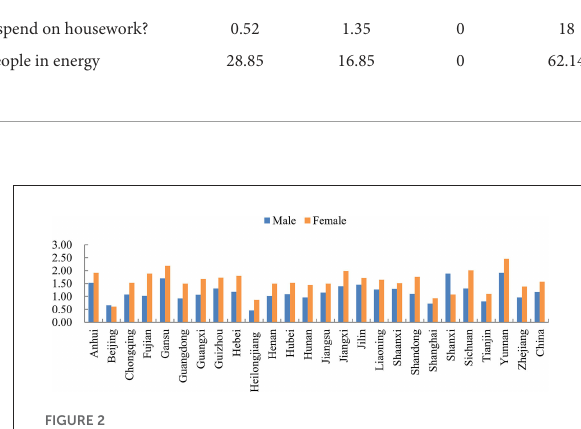
FIGURE2 Gender difference of housework